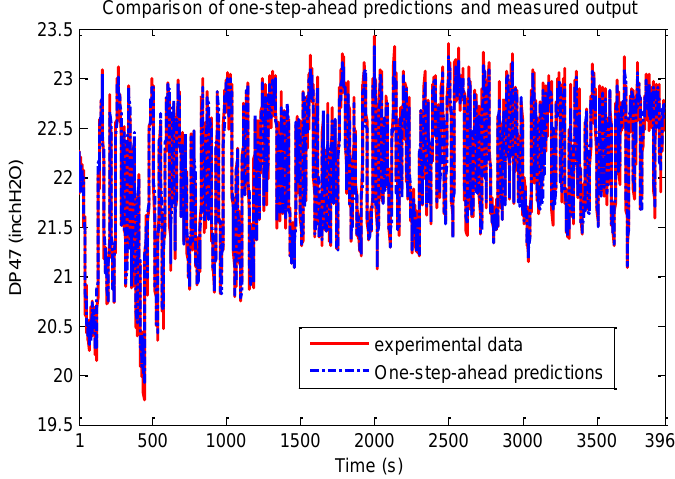
Figure 8. PRBS test - One-step-ahead predictions vs. experimental data.